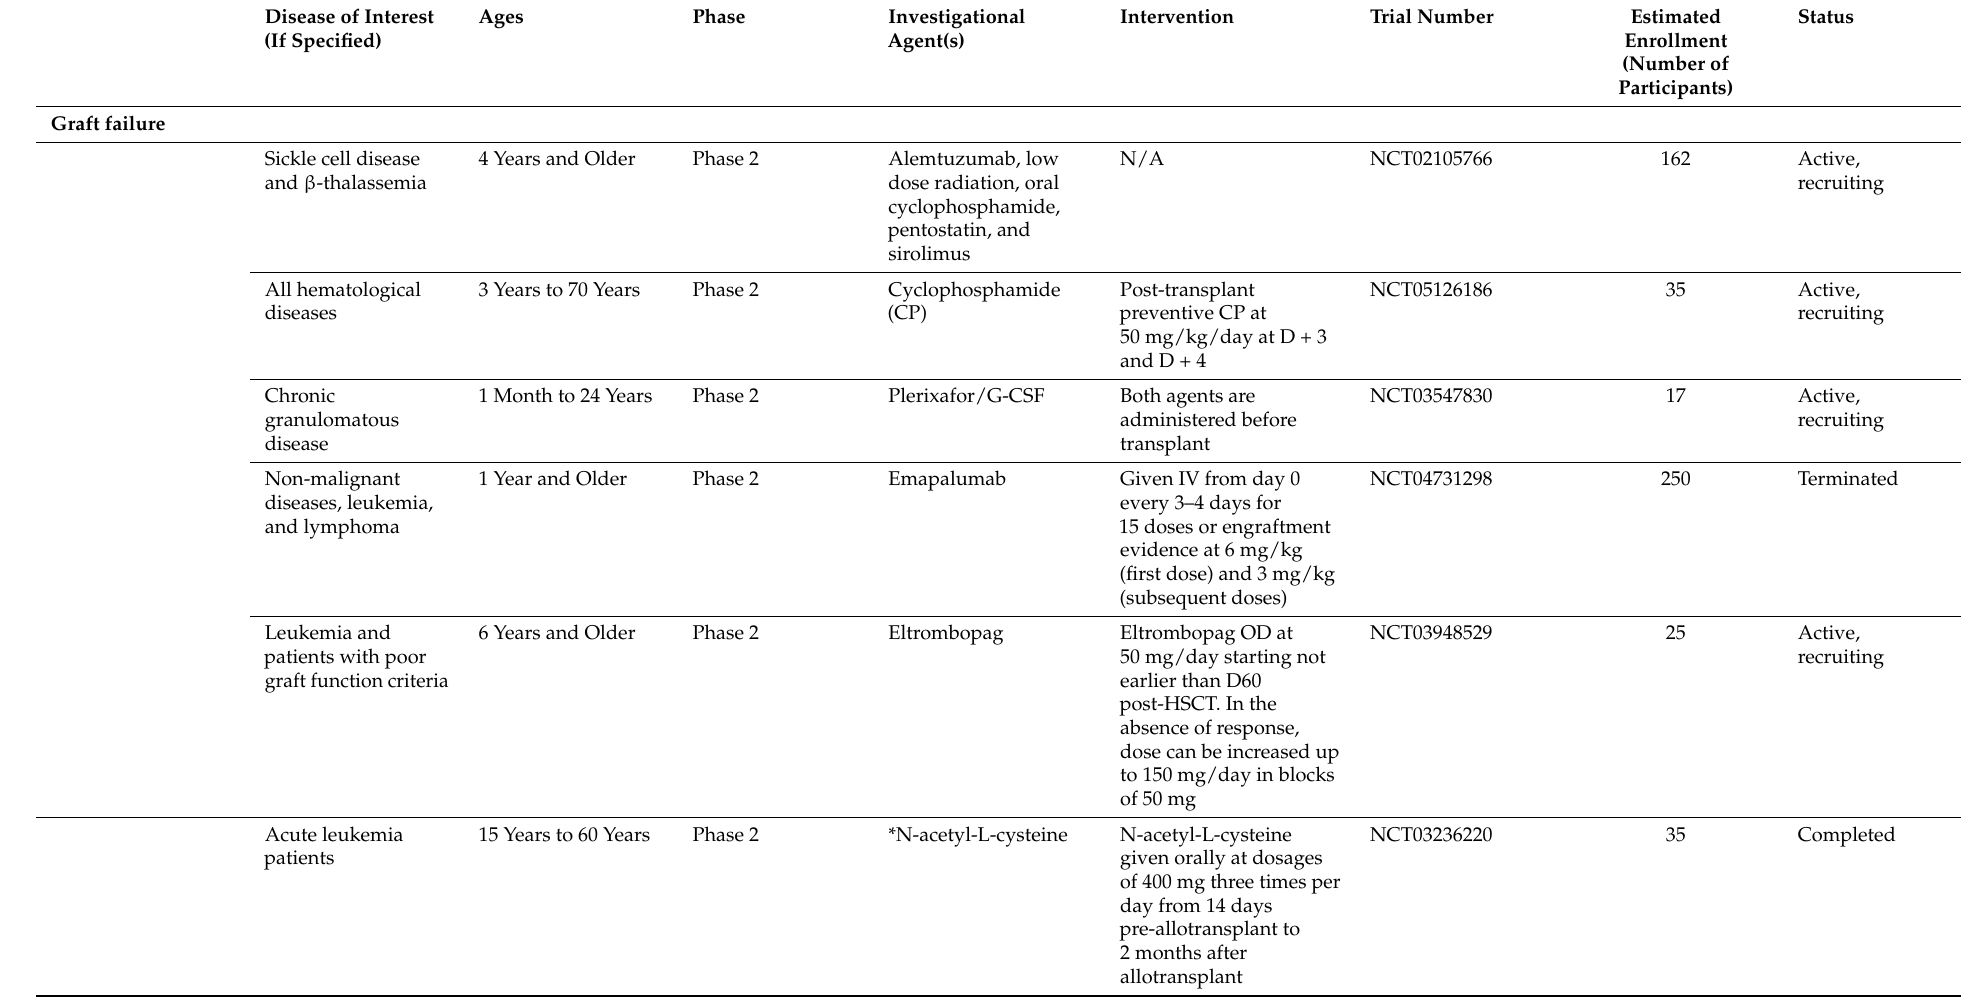
Intervention Trial Number Estimated Agent(s)